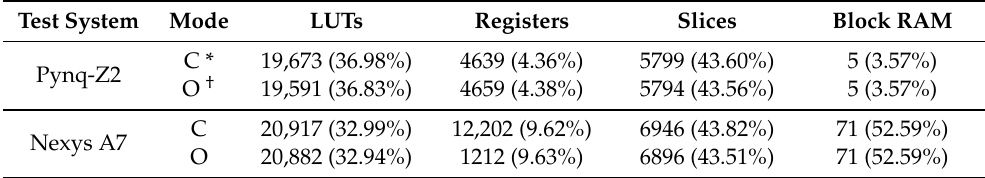
Table 2. Resource utilization for different test systems implementing 32-bit AXI4-Lite interfaces. Test